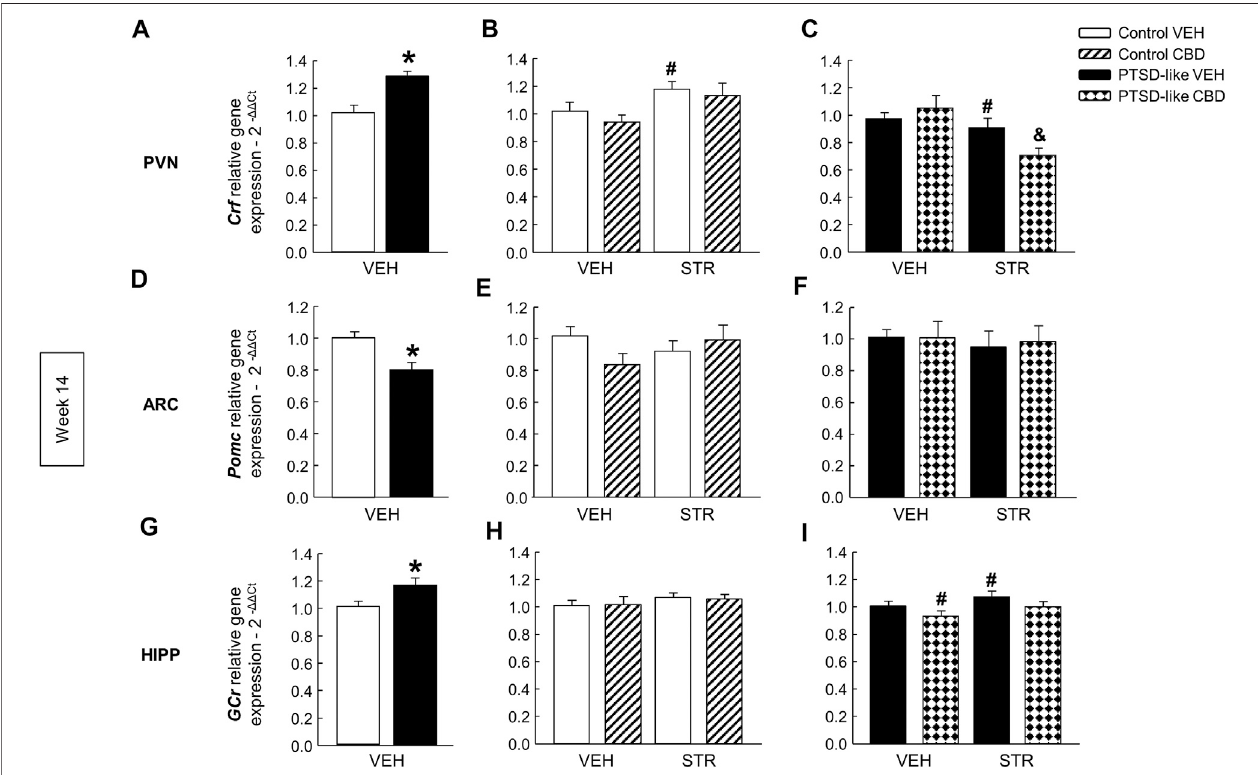
FIGURE8| Relativegeneexpression analysesofHypothalamus-Pituitary-Adrenal(HPA)axismarkersbyrealtimePCRatweek14.Comparativeanalysisbetween control and PTSD-like VEH-treated mice of the relative gene expression of corticotropin releasing factor ( Crf ) in the paraventricular nucleus (PVN) (A) , proopiomelanocortin ( Pomc ) in the arcuate nucleus (ARC) (D) , and glucocorticoid receptor ( GCr ) in the hippocampus (G) . Effects of CBD (20 mg/kg, i.p.) and/or STR (10 mg/kg,p.o.)administration,oritscorrespondingVEH,ontherelativegeneexpressionof Crf inthePVN (B,C) , Pomc intheARC (E,F) ,and GCr intheHIPP (H,I) of control and PTSD-likemice. Columns represent the means and vertical lines ± SEMof 2 - ΔΔ Ct . *, Values from PTSD-likemice that aresigni fi cantlydifferentfrom control mice(Student ’ s t -test, p < 0.05).#,ValuesfromCBD-orSTR-treatedmicethataresigni fi cantlydifferentfromVEH-treatedmice(Two-wayANOVA, p < 0.05).and,Values from CBD plus STR-treated mice that are signi fi cantly different from CBD- and STR-treated mice (Two-way ANOVA, p < 0.05). Mice exposed to the PTSD-like model: N(VEH) (cid:2) 10, N(CBD) (cid:2) 9, N(STR) (cid:2) 9, N(CBD plus STR) (cid:2) 10; control mice: N(VEH) (cid:2) 10, N(CBD) (cid:2) 9, N(STR) (cid:2) 9, N(CBD plus STR) (cid:2)